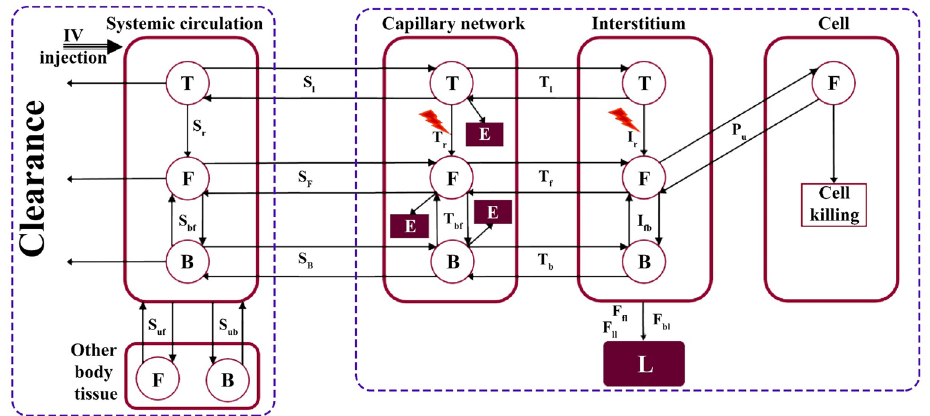
Figure 7. According to the drug transport processes, a multi-compartment model is presented, demonstrating the exchanges of therapeutic agents with tissues in the systemic circulation compartment, the elimination of therapeutic agents in the microvascular network due to immune systems and endothelial cell, excretion by the lymphatic system in the interstitium, and cellular uptake. T; ThermoDox, F; Free drug, B; Bound drug, L; Lymphatic system, E;